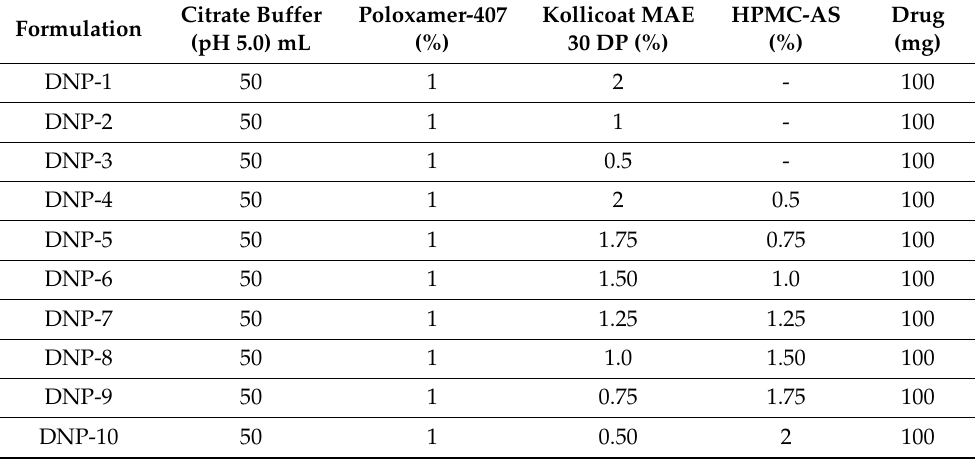
Table 1. Formulation chart for the preparation of Kaempferol Nps (DNP-1 to DNP-10).